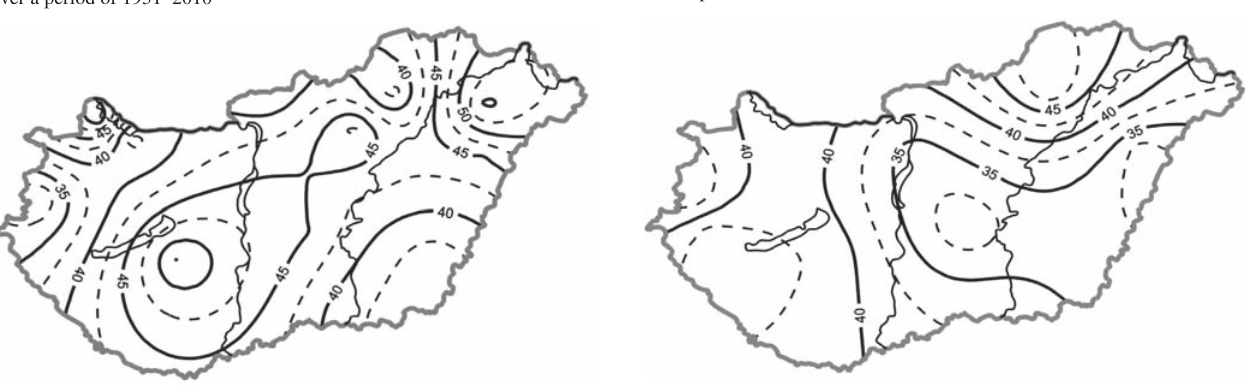
Figure 9 – The mean values of coeffi cients of variation (CV) of the absolute daily maxima of precipitation in winter measured at 16 stations over a period of